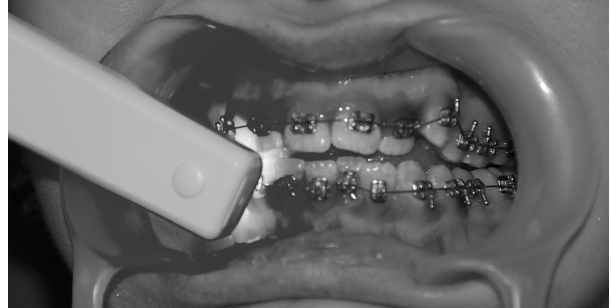
Table 4. Values of the dental indices in the second group before and after treatment ( n ¼ 30).